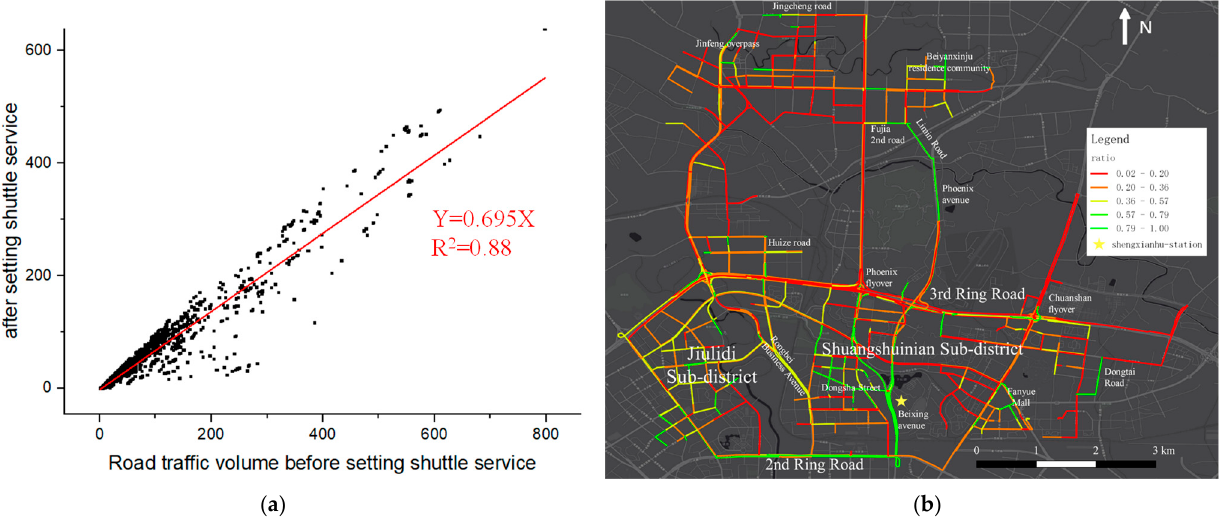
Figure 12. The potential reduction in traffic volume. ( a ) Relationship of traffic volume; ( b ) reduced ratio distribution.